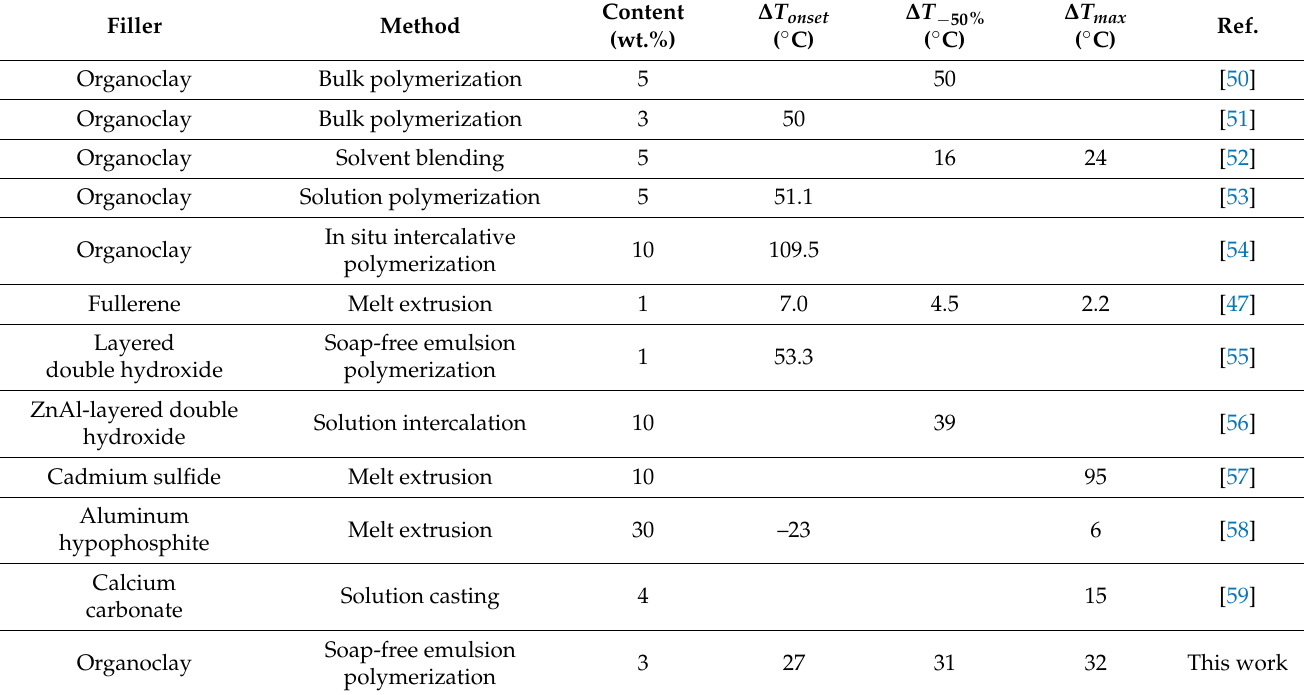
Table 5. Parameters of enhanced thermal properties.